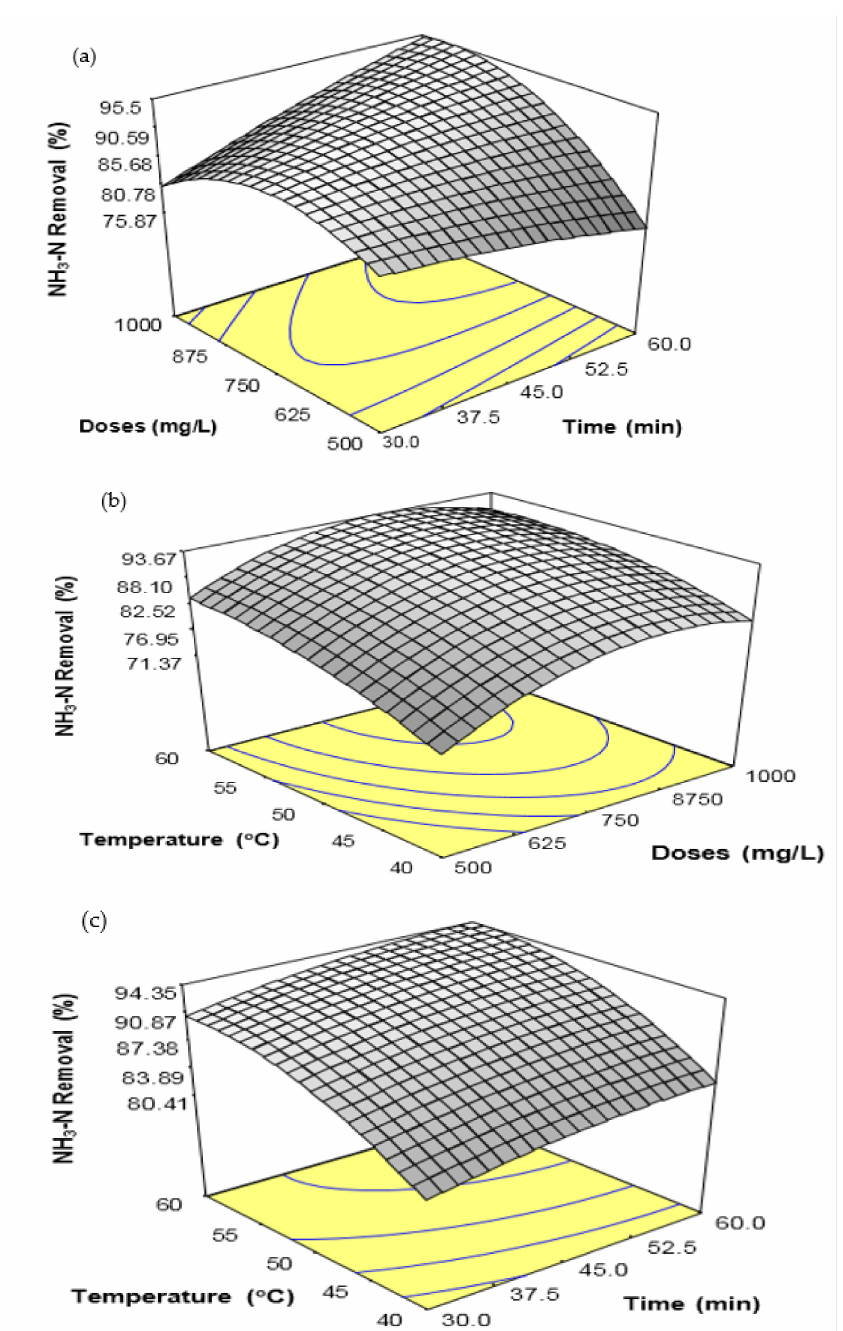
Figure 2. Response surface plots for the removal of NH 3 -N from SRPE using FeSO 4 · 7H 2 O waste as a coagulant. ( a ) Interaction effect between coagulation time and FeSO 4 · 7H 2 O waste doses, ( b ) In- teraction effect between FeSO 4 · 7H 2 O waste doses and temperature, and ( c ) Interaction between coagulation time and